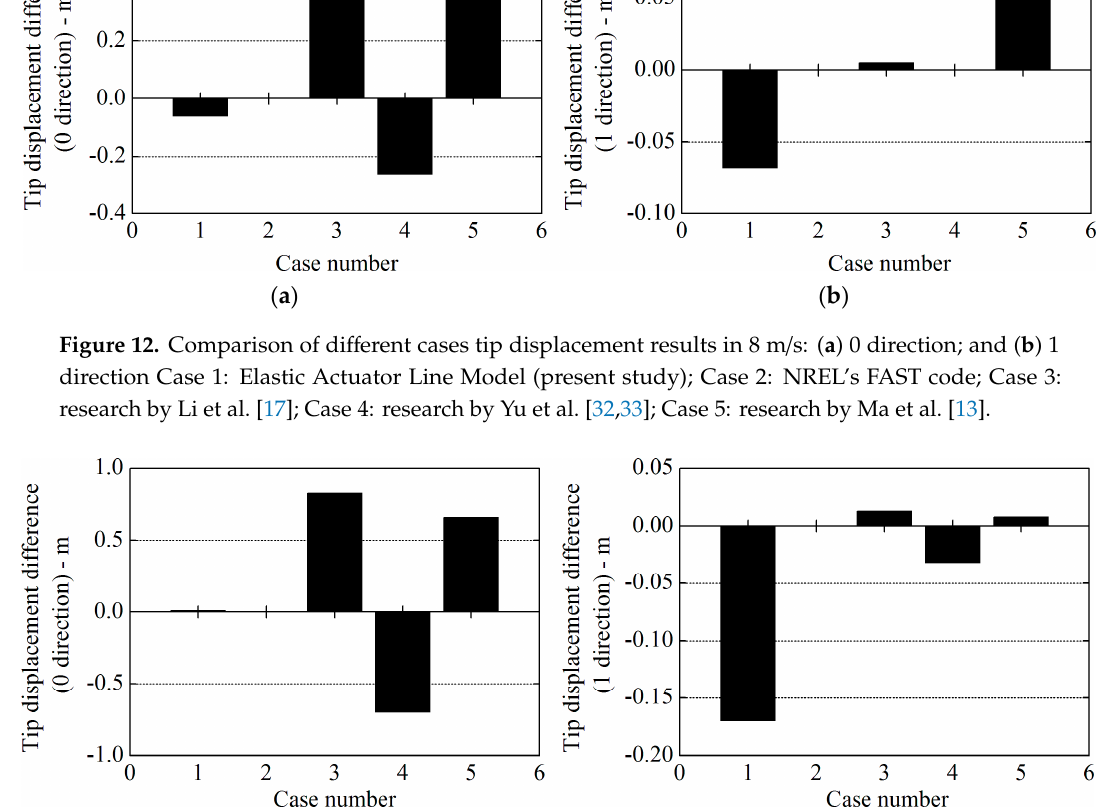
( b ) Figure 14. Comparison of the tip displacement results between elastic actuator line model (EALM) and NREL’s FAST code at different wind speeds: ( a ) in 0 direction; and ( b ) in 1 direction. Table 9. Comparison of the tip displacement relative errors between elastic actuator line model (EALM) and NREL’s FAST code at different wind speeds. Wind Speed (m/s)